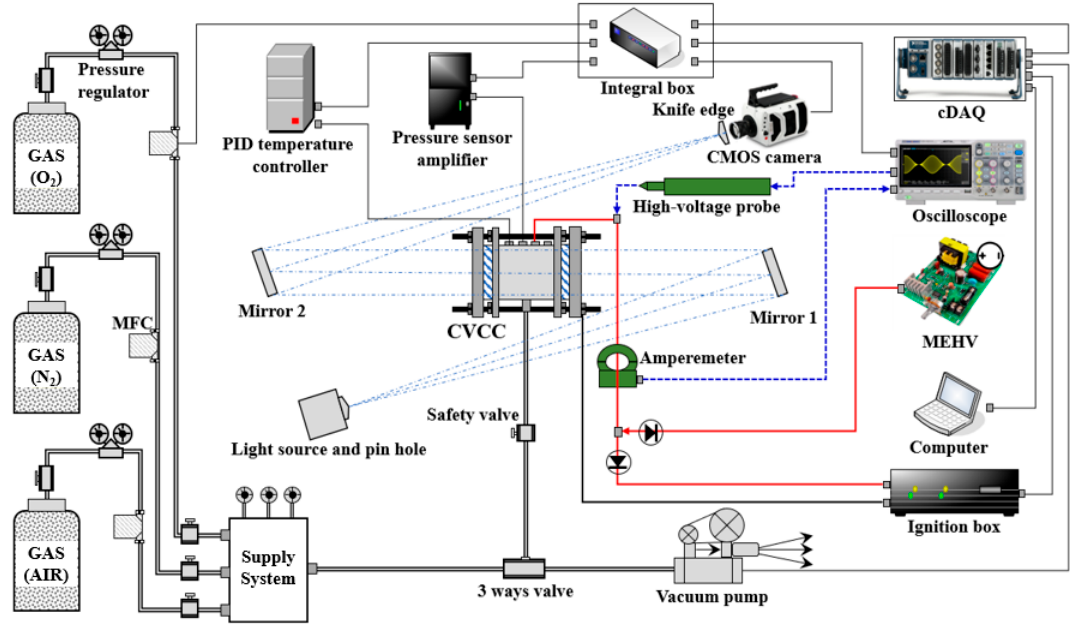
Figure 5. A schematic diagram of experimental devices and constant volume chamber systems. Table 4. Specifications of experimental devices and CVCC system.